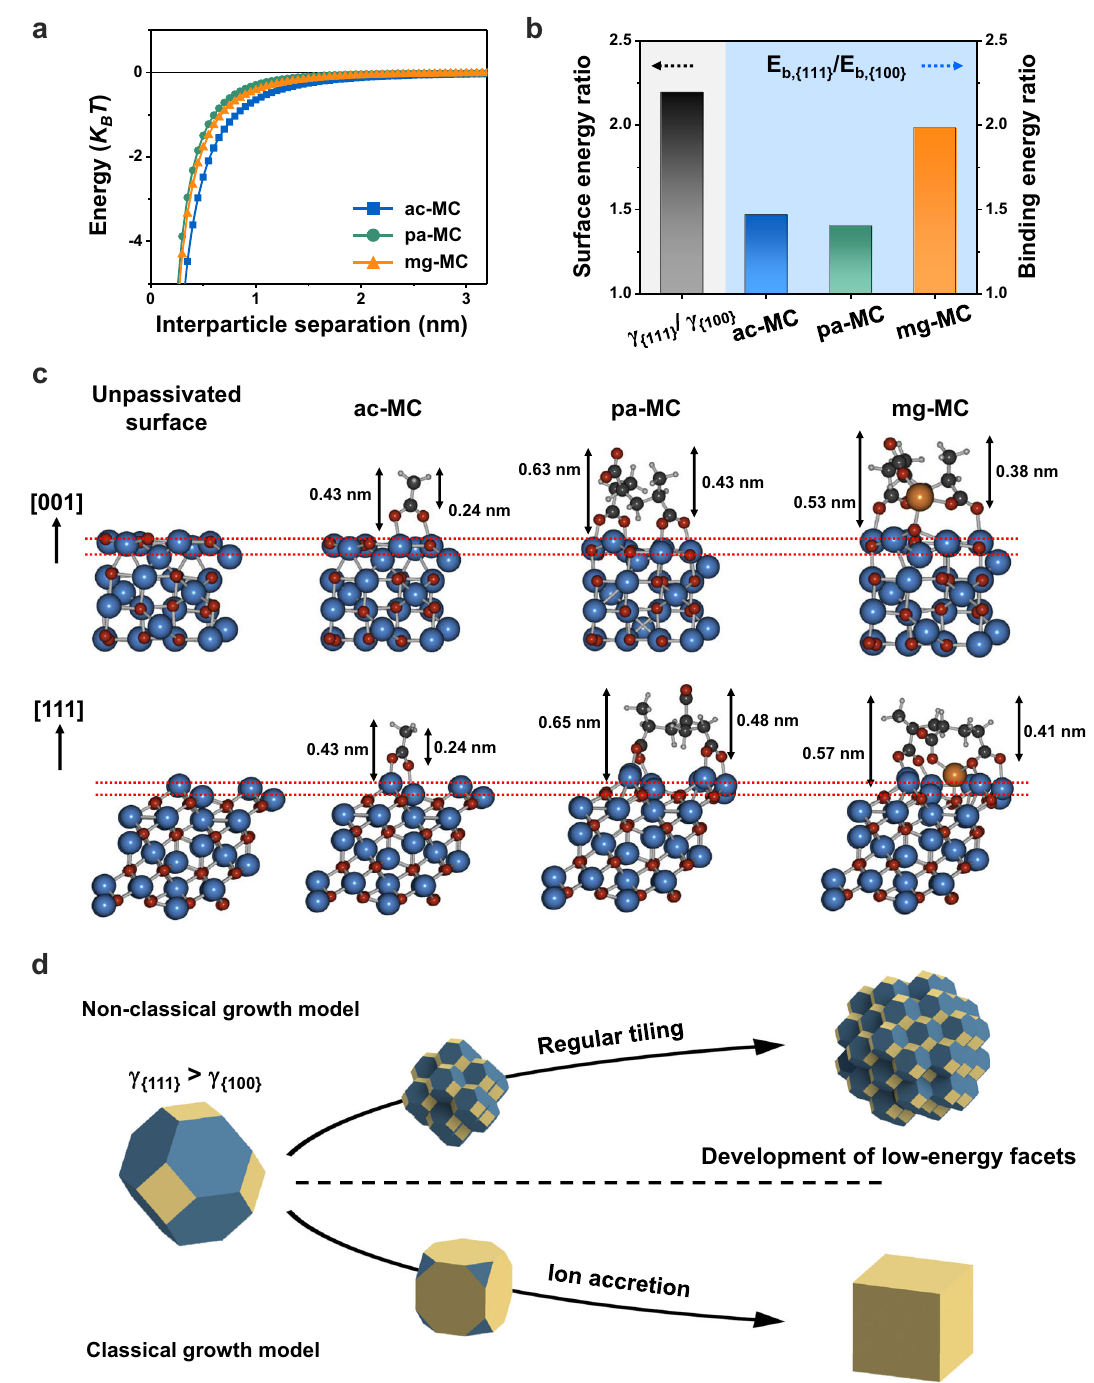
Fig. 7 Driving force guiding the variation in the BNC alignment during OA. a Theoretical model of the pair interaction potential between BNCs as a function of the inter-BNC distance calculated by the extended DLVO theory, considering van der Waals attraction, electrostatic repulsion, and magnetic dipole – dipole interactions. b Surface energy ratio of unpassivated BNCs and ratio of the binding energies of surface ligands for the {111} and {100} facets, as calculated by DFT. c Side view of the BNC surface conformation and surface ligand simulated by DFT calculations after relaxation. Relaxed slab structure of BNC before and after surface ligand coordination on the {001} and {111} facets. The blue, black, white, red, and orange spheres indicate Fe, C, H, O, and Mg atoms, respectively. The red dotted auxiliary lines illustrate the surface distortion relative to the unpassivated Fe 3 O 4 surface. d Classical facet overgrowth and nonclassical regular tiling